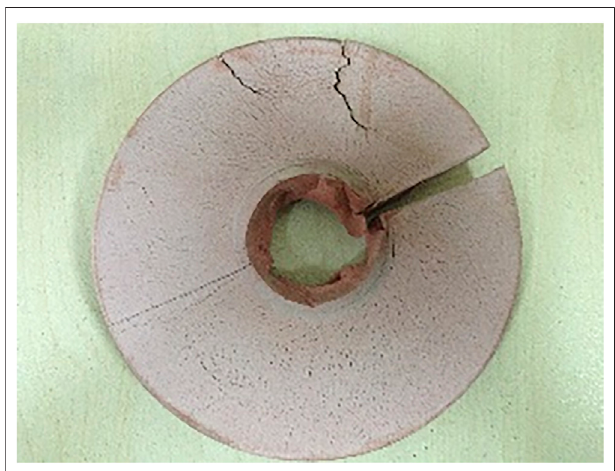
FIGURE 1 | Appearance of waste silicone